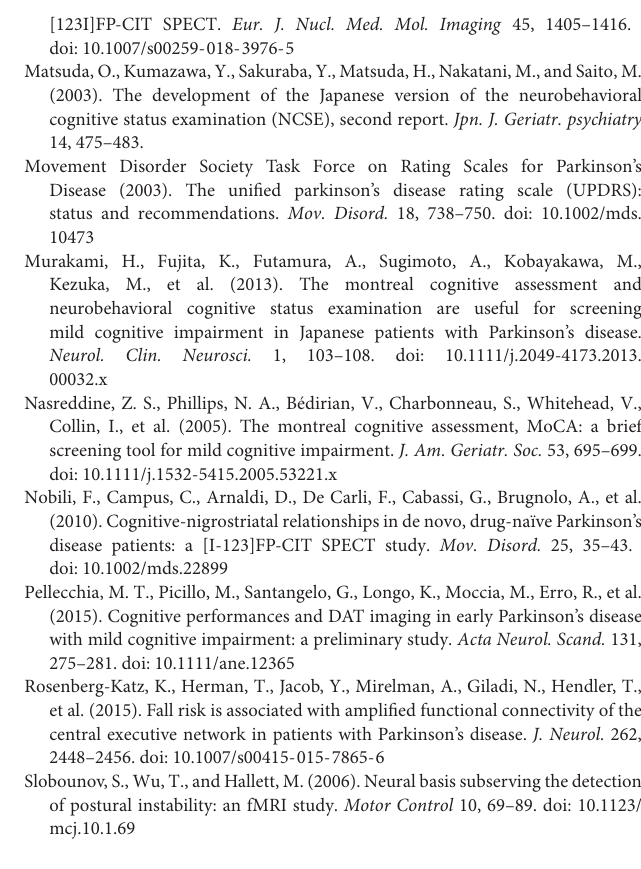
TABLE S1 | All raw data of participants included in this